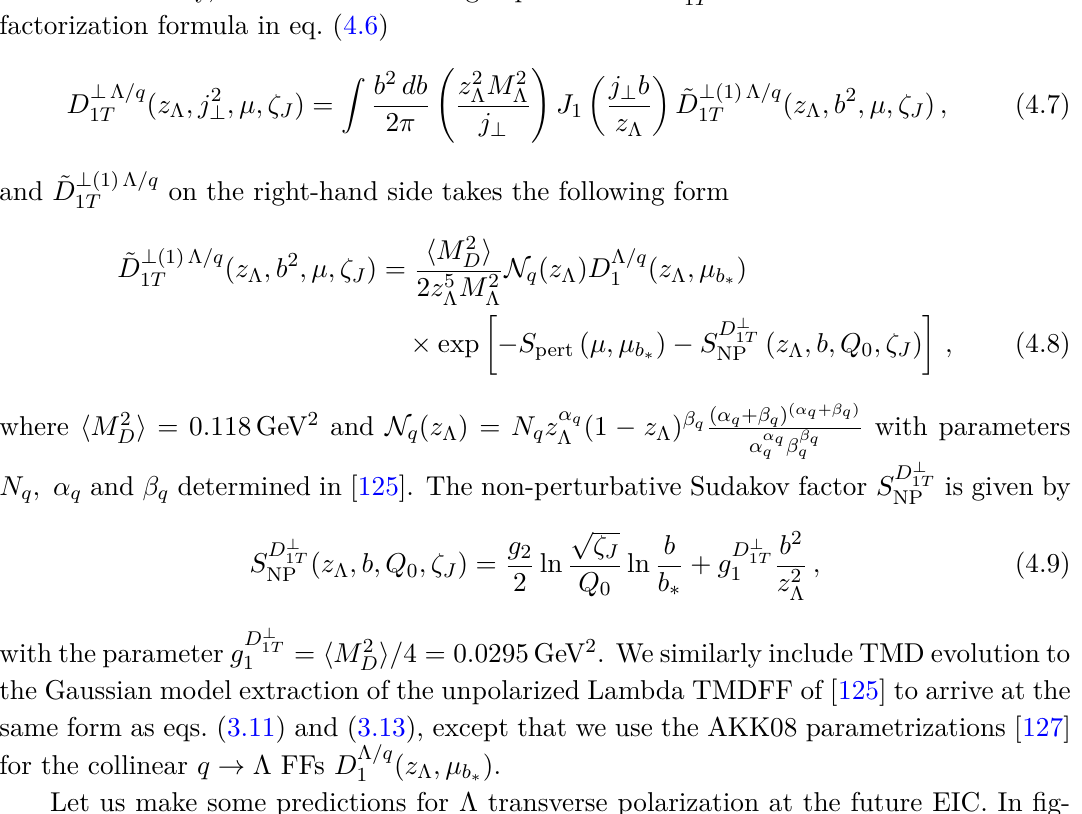
that is needed in the 1 T